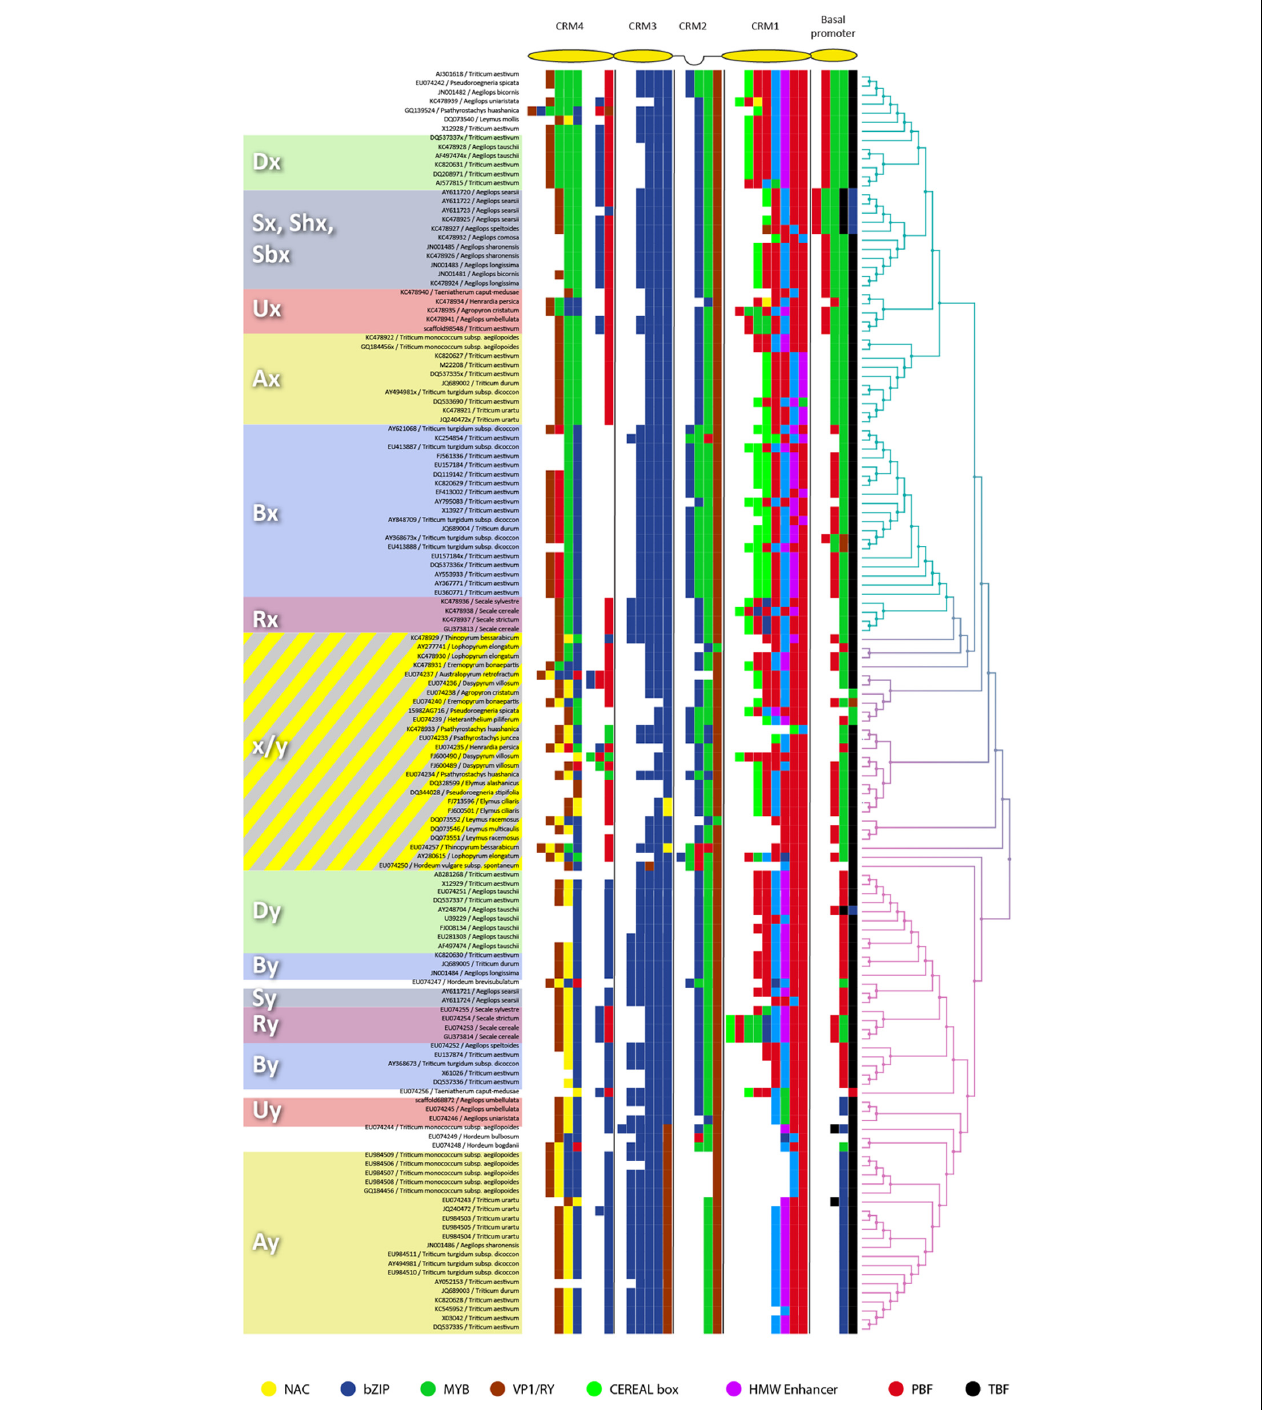
FIGURE 1 | The phylogenetic tree based on the 900 bp long 5 (cid:48) -UTR of high molecular weight glutenin subunit (HMW GS) genes of 139 Triticeae species. All publicly available (at the time of writing) sequences were used. The sequence data was obtained from the NCBI nucleotide database. The tree was build using the Neighbor-joining method of the MEGA6 software (Tamura et al., 2013). The blue branch marks the x-type promoters, the magenta branch the y-types. The transient gradient represents the hybrid type promoters. Typically, species belonging to the genome E are placed on this transient part. Condensed promoter view is shown where only the motifs and their order are presented. The accession and the species are written in small letters. The motifs to generate the promoter profiles are as follows (in regex format): bZIP (including SPA) - (TGACGT| [GA]TG[AT]G[TA]CAT| GTCAT| GATGACGTGTC); MYB - (TAACAA| AACAAA| AAACCA); NAC – CATGTG; VP1 – CATGCA; TBF - TATA[AT]A[AT][AG]; PBF - TG[GC]A{3,4}[GC]; CEREAL Box - GACATG[GC]TTAGAAG[TC][TA]TTGAGTG; HMW Enhancer - [TG]TTTT[GAC][GC](AAA| CAA| AA)GC[TA]CCAATTGCTCCTT[GA]CTTATCCAGCT.